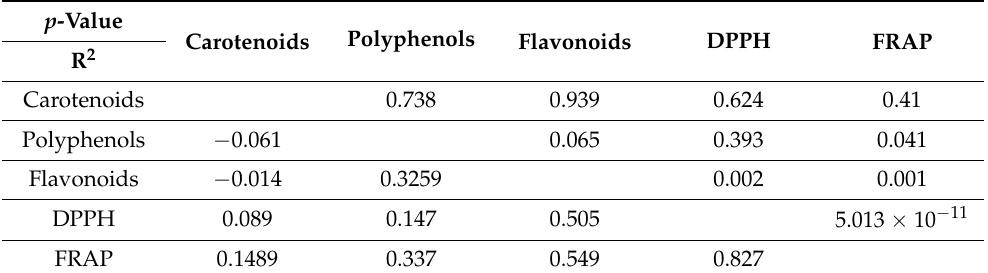
Table 3. Pearson correlation analysis performed on carotenoids, polyphenols, flavonoids, FRAP, and DPPH data of fresh microalgal